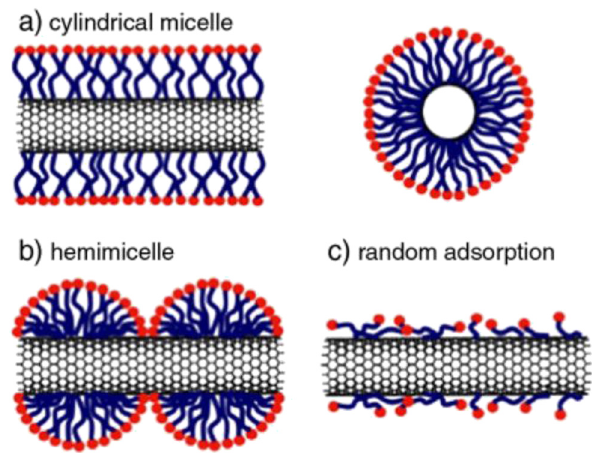
Figure 8: Schematic illustration of various surfactant assembly structures on a SWNT, including ( a ) cylindrical micelles, ( b ) hemimicelle, and ( c ) random adsorption [ 91 ]